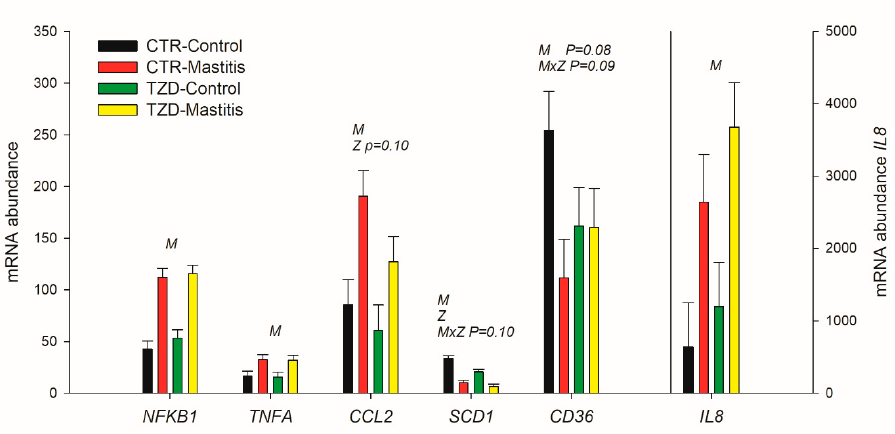
Figure 6. Effect on leukocytes differential and phagocytosis of 2,4-thiazolidinedione (TZD) daily injection and intramammary infusion (IMI) with Strep. uberis (IMI) in Saanen dairy goats. Reported are the percentages of granulocytes (PMN) and monocytes and their percent phagocytosis. Letters in the graph denote significant ( p < 0.05) effects of time (T) and 2,4-thiazolidinedione treatment (Z).